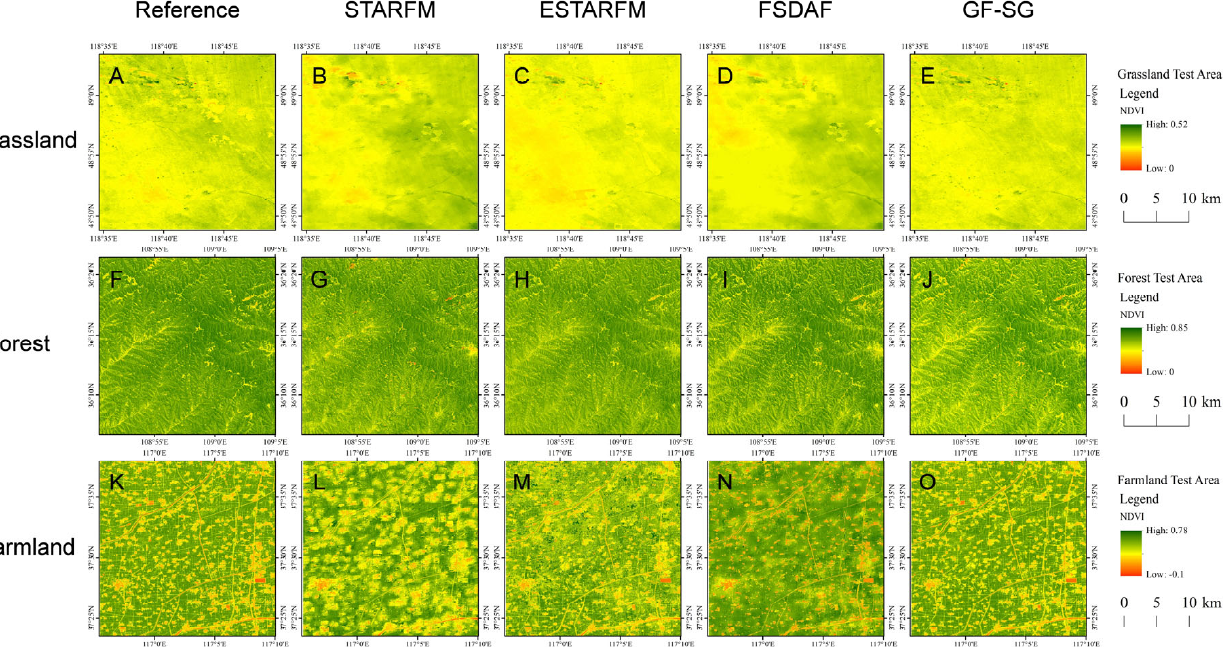
Table 1. RMSE of the fusion results of different methods.